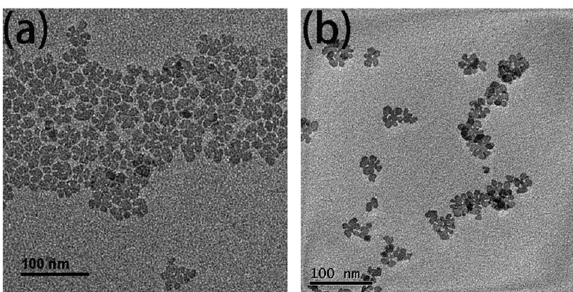
Figure 1: TEM images of Gd 2 O 2 S:Eu before ( a ) and after modi fi ca - tion ( b ) .